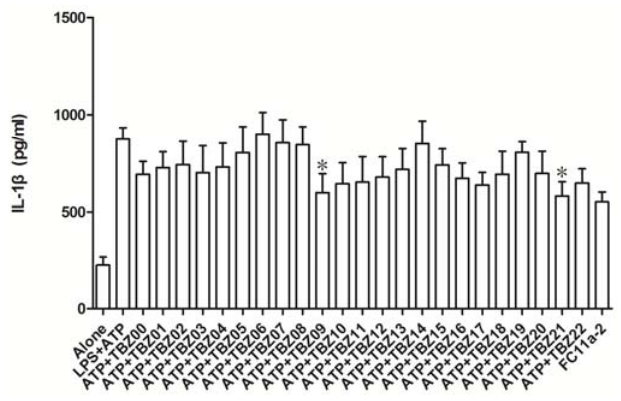
Figure 3. The effects of TBZ series compounds (10 µ M) on IL-1 β productions in THP-1 cells activated by LPS plus ATP. (The marked compounds exhibit the best inhibition towards IL-1 β production.)